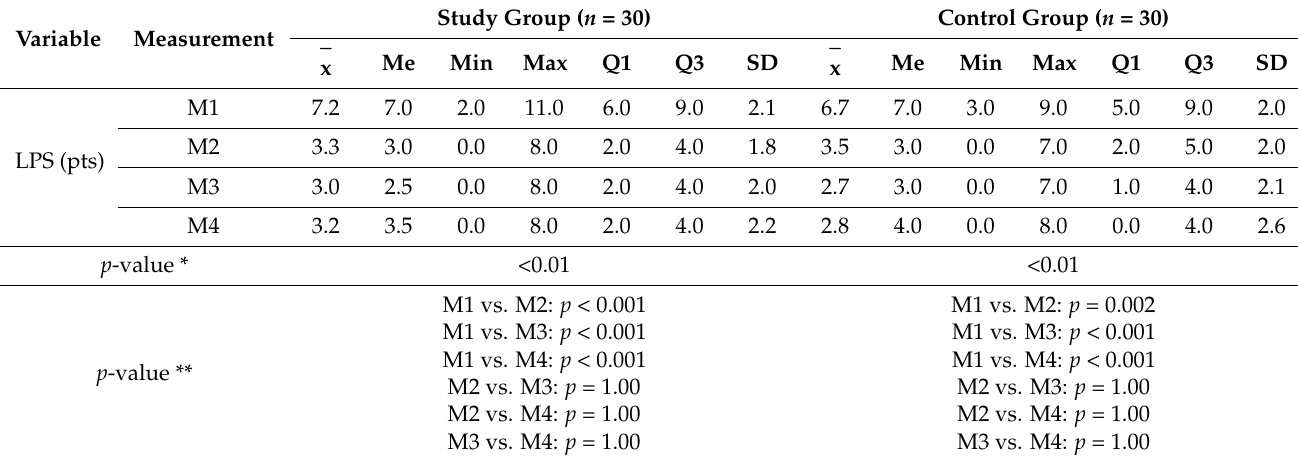
Table 3. The comparison of changes in pain scores (LPS) between the study and control group. Variable